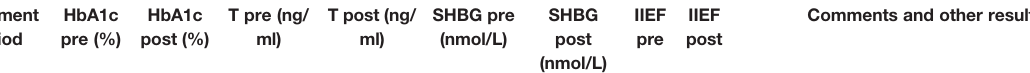
TABLE 2 | Human studies on the effects of GLP1 RAs, DPP4is and SGLT2 on male HPG male